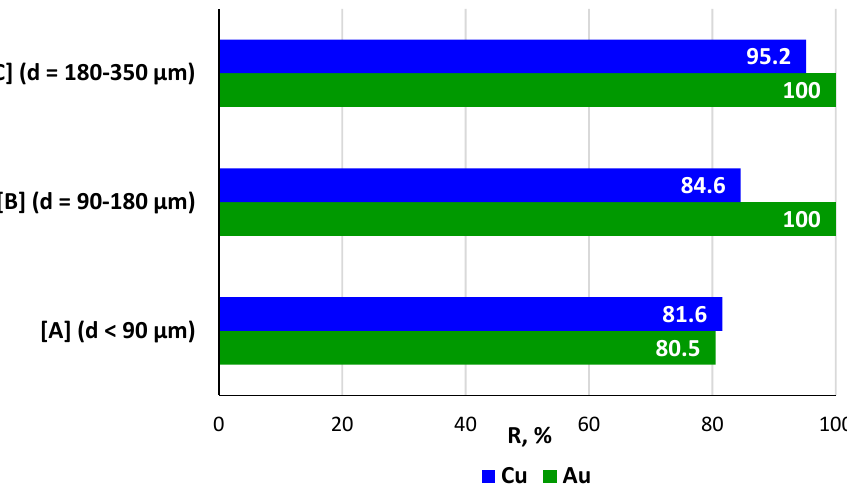
Figure 9. Impact of raw material particle size on the degree of gold and copper leaching. Experimental conditions: i = 0.66 A·cm –2 , t ex = 2 h, S/L = 8.6 g·L –1 , and C HCl = 6 M.